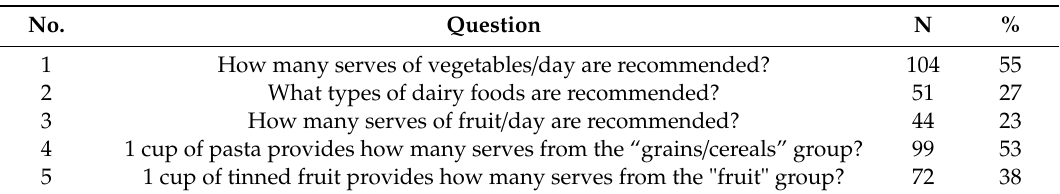
Table 2. Number of participants answering food group nutrition questions (for children aged 2–3 years, per the Australian Dietary Guidelines (ADG)) correctly ( n = 188).